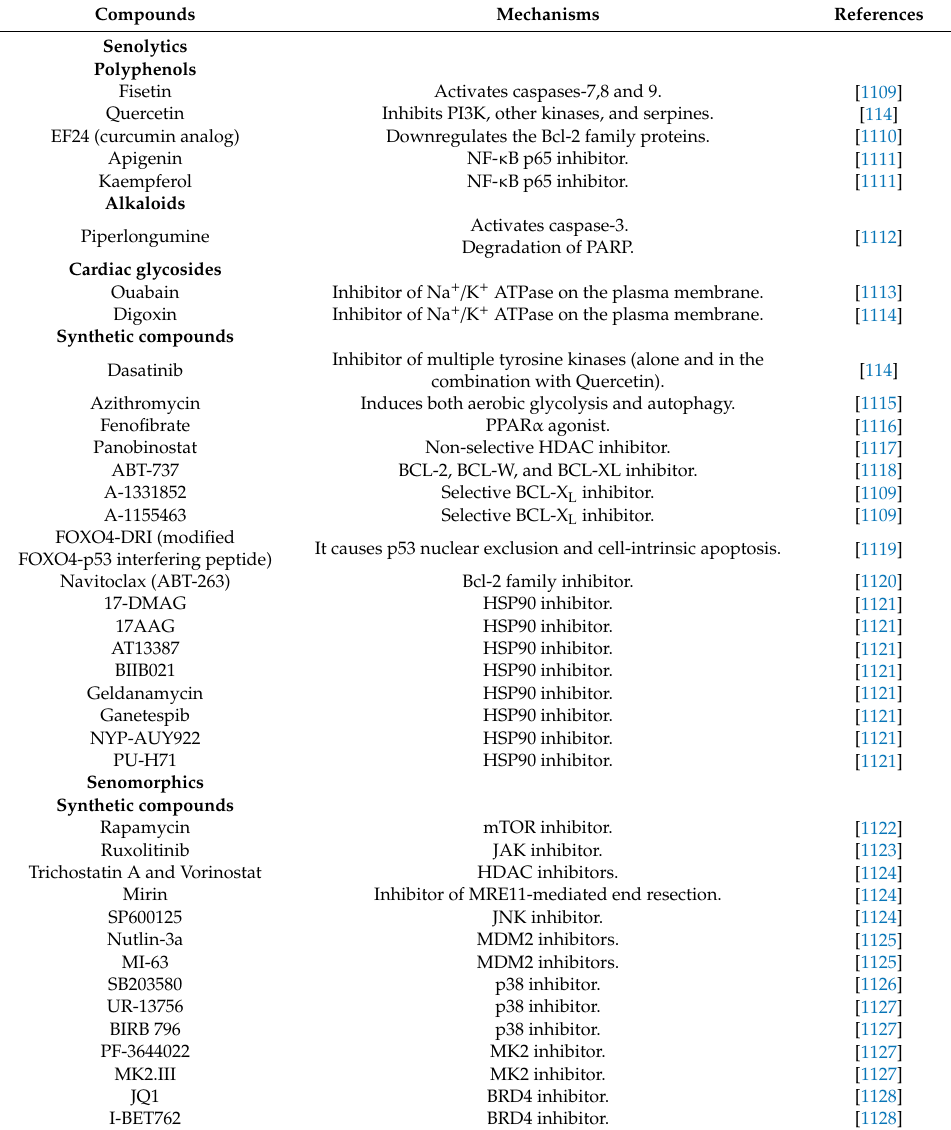
Table 5. Compounds with senotherapeutic